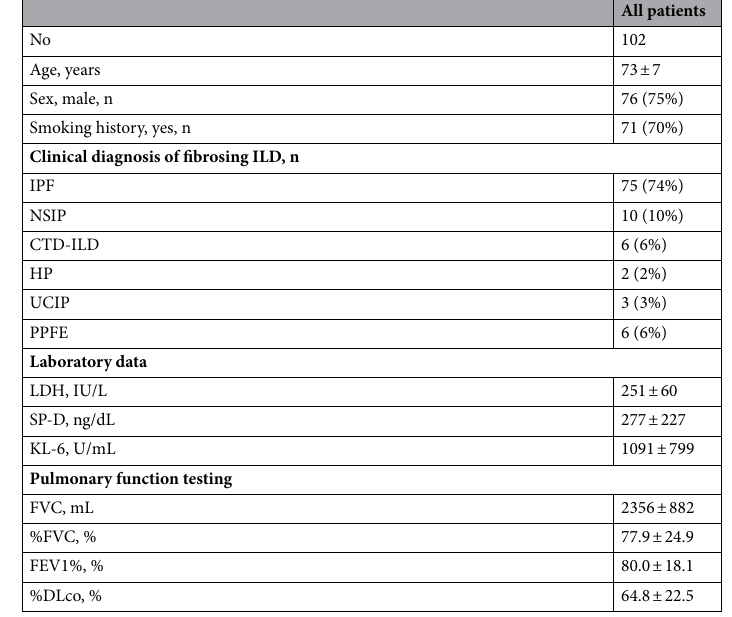
Table 1. Baseline characteristics of patients. Data are presented as mean ± SD. ILD interstitial lung diseases, IPF idiopathic pulmonary fibrosis, NSIP non-specific interstitial pneumonia, CTD-ILD connective tissue disease–associated interstitial lung disease, HP fibrotic hypersensitivity pneumonitis, UCIP unclassifiable interstitial lung disease, PPFE pleuroparenchymal fibroelastosis, LDH lactate dehydrogenase, SP-D surfactant protein-D, KL-6 Krebs von den Lungen-6, FVC forced vital capacity, FEV forced expiratory volume in 1 s, DLco diffusing capacity for carbon monoxide.